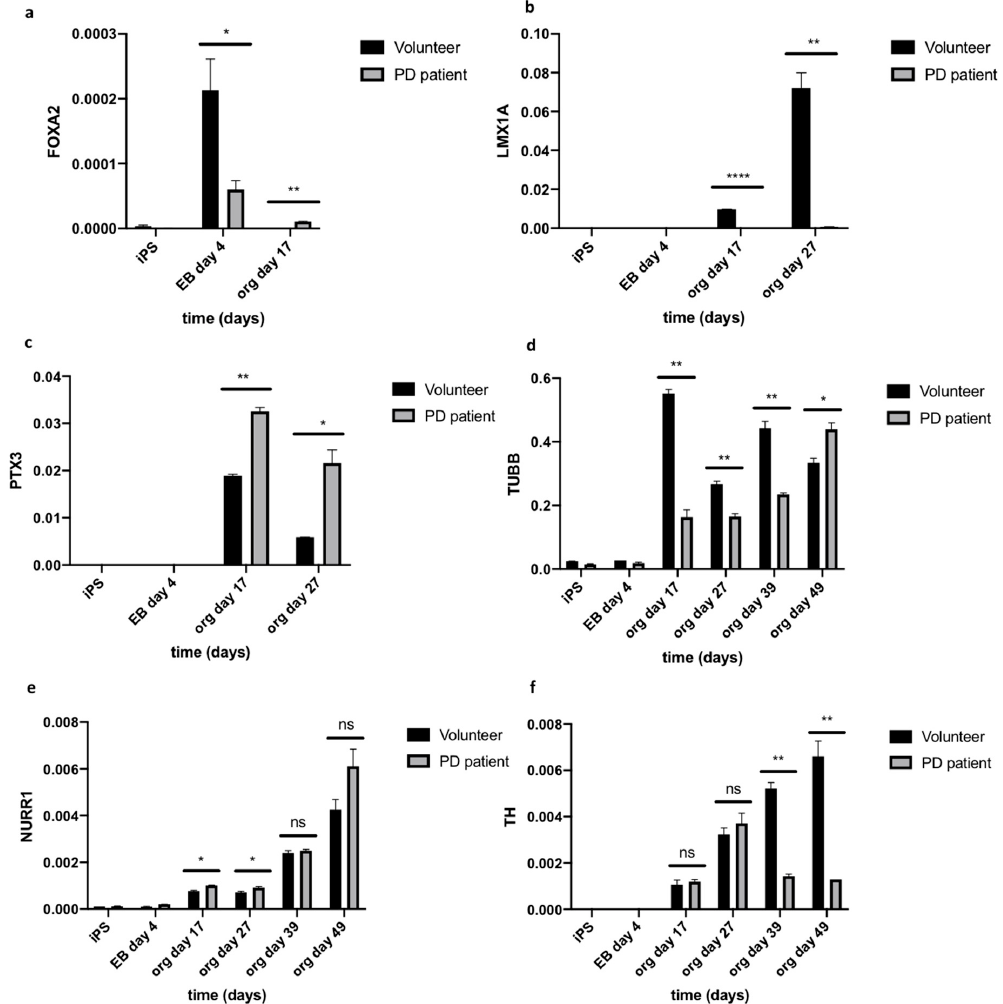
Figure 4. Expression (RT-qPCR) of early (FOXA2, LMX1A, PTX3) and late neurons markers (TUBB3, NURR1, TH) in organoids derived from healthy volunteer and PD patient. At each time point (day 0, 4, 17, 27, 39, 49 of di ff erentiation) the RNA samples are collected from three organoids ( n = 3). ( a ) The expression of FOXA2 is significantly lower in PD organoids versus control organoids on day 4, whereas it is higher comparing to control on day 17. * p < 0.05, ** p < 0.01 ( b ) The expression of LMX1A is significantly higher in control organoids versus PD organoids on day 17 and 27. **** p < 0.0001, ** p < 0.01. ( c ) The expression of PTX3 is significantly higher in PD organoids versus control on day 17 and 27. ** p < 0,01, * p < 0.05. ( d ) The expression of TUBB3 is higher in control organoids on day 17, 27,